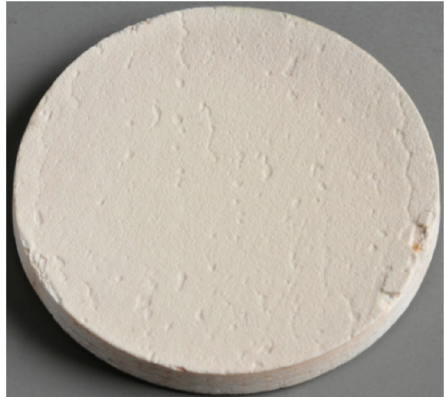
Figure 9. Photograph of VLPPS YAlO 3 coating on FW12 after 1010 cycles of burner rig testing.